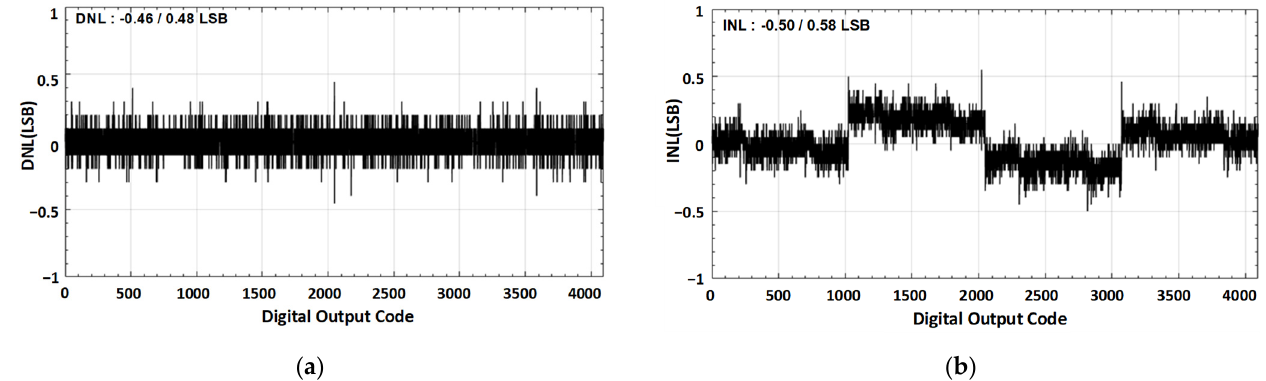
Figure 14. Static performance parameter ( a ) DNL, and ( b ) INL.